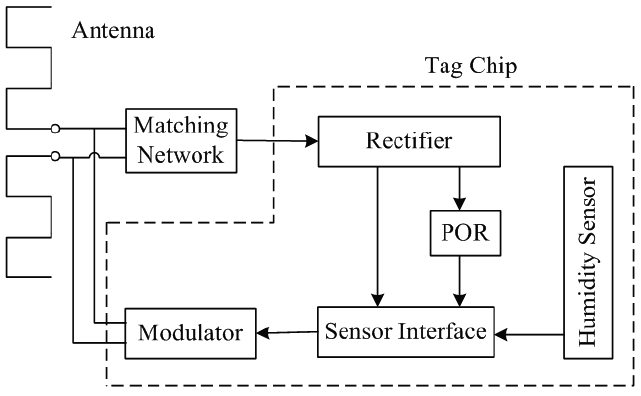
Figure 1. Architecture of the proposed wireless